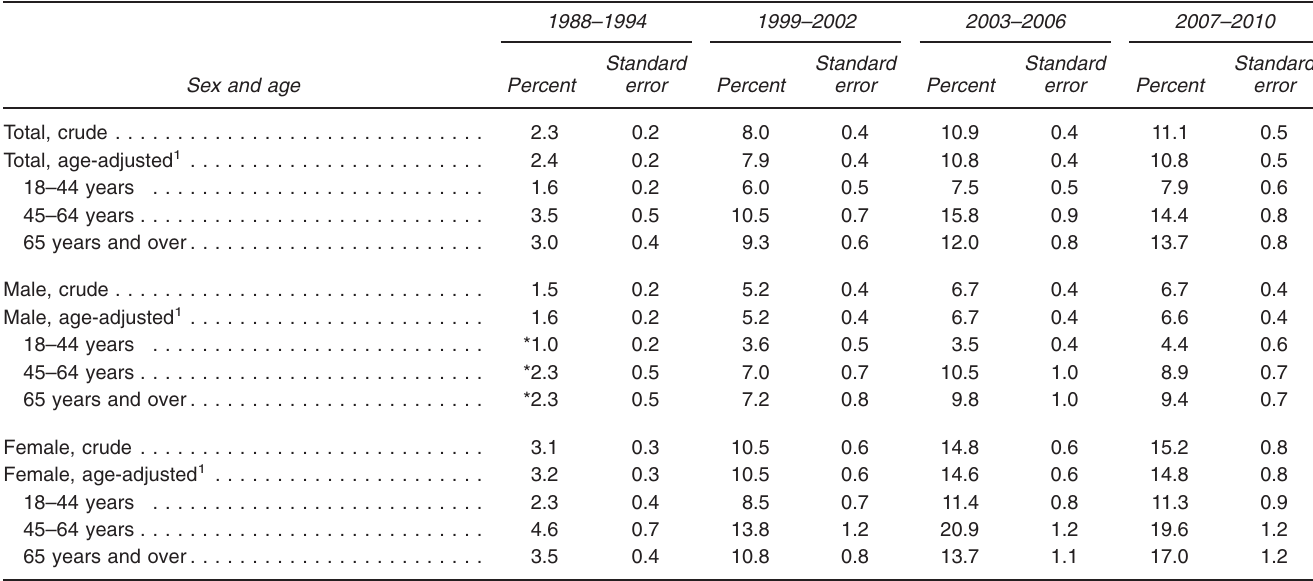
Data table for Figure 25. Use of prescription antidepressants in the past 30 days among adults aged 18 and over, by sex and age: United States, 1988–1994 through 2007–2010 Excel and PowerPoint: